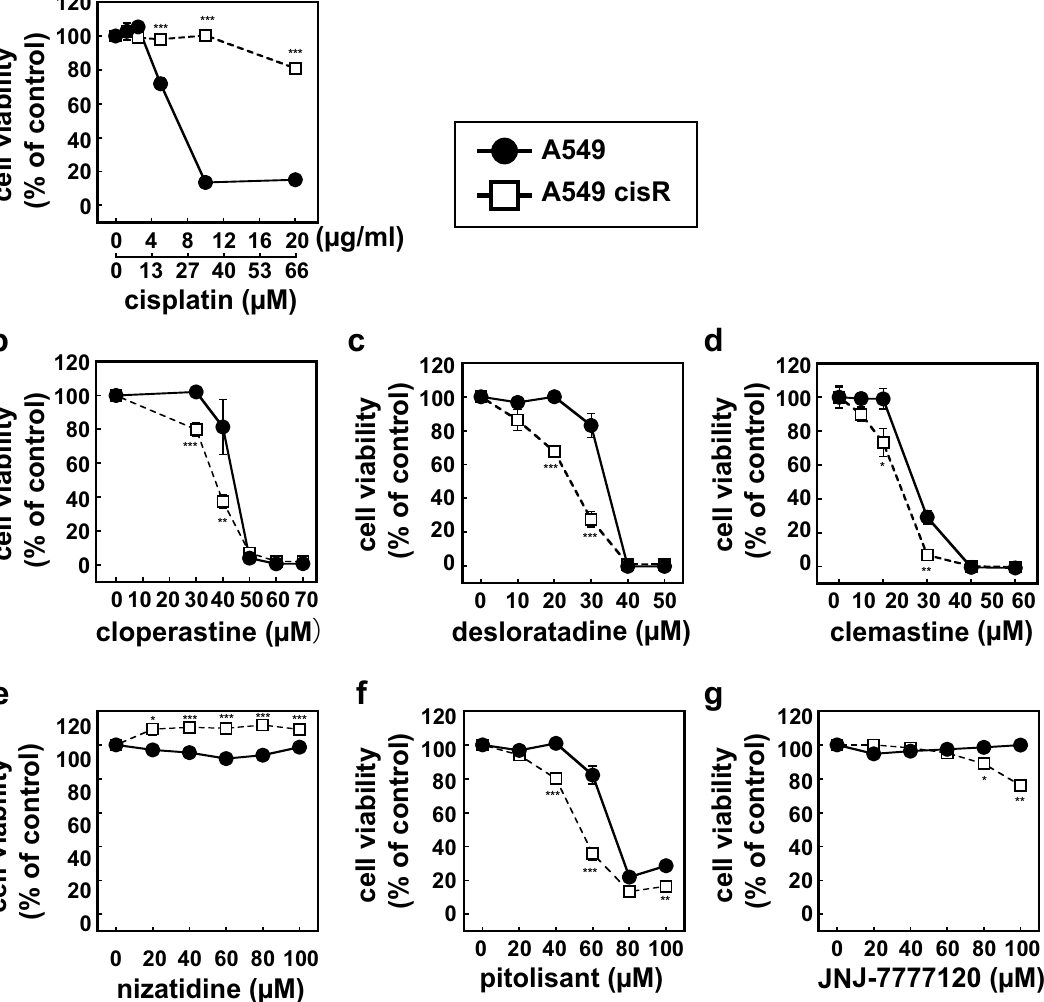
Figure 10. Cisplatin-resistant A549 cisR cells are selectively killed by histamine H1 receptor antagonists. A549 cisR cells were established from parental A549 lung cancer cells and subcultured in the presence of 3 µg/ ml cisplatin. A549 cisR cells (open squares) and A549 cells (filled circles) were cultured for 3 days with the indicated concentrations of cisplatin ( a ); the histamine H1 receptor antagonist cloperastine ( b ), desloratadine ( c ), or clemastine ( d ); the H2 receptor antagonist nizatidine ( e ); H3 receptor antagonist pitolisant ( f ); or H4 receptor antagonist JNJ-7777120 ( g ). Cell viability was then assessed during the final 5 h of the culture using WST-8 colorimetric assays. The results are presented as means ± S.D. of sextuplicate ( a – d ) or quadruplicate ( e – g ) samples. Four separate experiments yielded essentially the same results. Note that only H1 receptor antagonists resulted in 0% cell viability. The significance of the difference between the results from A549 and A549 cisR cells at the same concentration of the indicated compound was determined with ANOVA (***p < 0.001; **p < 0.01; *p <